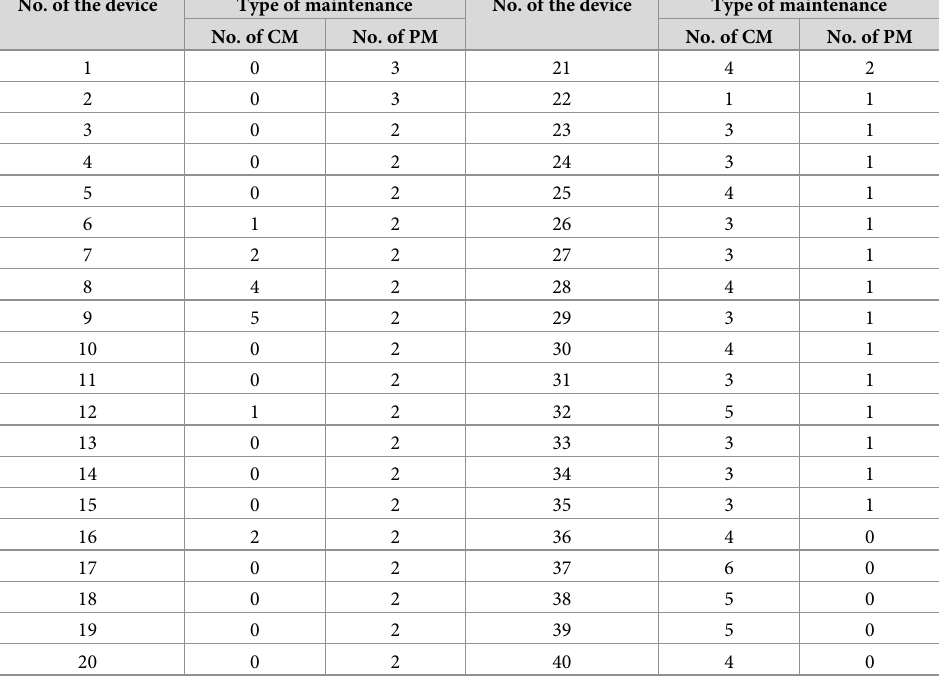
Table 3. List of the tested device population. No. of the